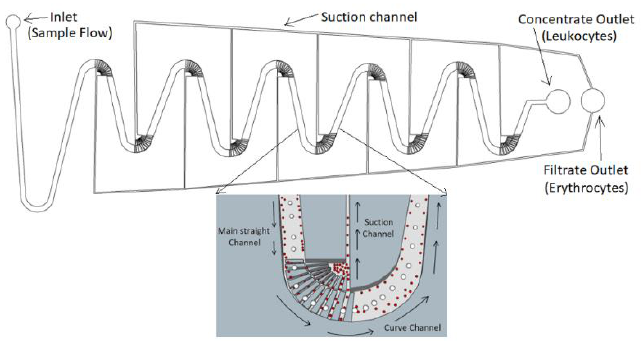
Figure 1. Our separation chip has three types of channel: (i) a main straight channel, (ii) curve channels, and (iii) suction channels. The main straight channel has the inertial migration to move the cells into different equilibrium regions. The curve channels (with the close-up view in the inset) push the white blood cells (WBCs) toward the outer part while the red blood cells (RBCs) move toward the inner part. The suction channel allows the RBCs to be sucked away. Note: the main dimensions of the microchannels used in this work are: W = 200 μm, H = 58 or 85 μm, radius of curvature = 100 μm, and W (suction) = 7 μm.